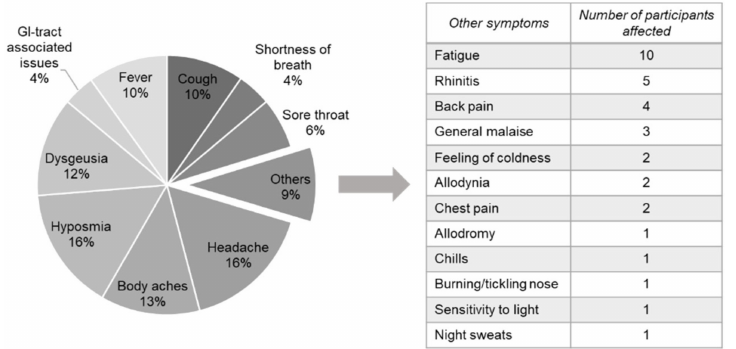
Figure 7. Symptoms experienced by blood donors during a symptomatic SARS-CoV-2 infection. Most commonly reported symptoms are shown on the left, other symptoms experienced are listed on the